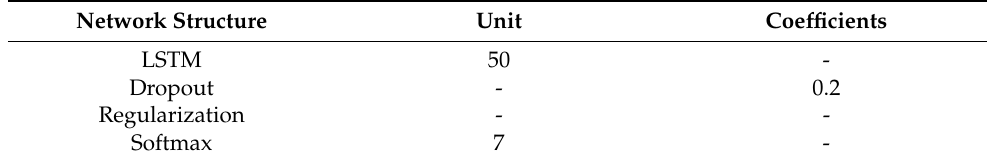
Table 3. Related parameters of neural network.